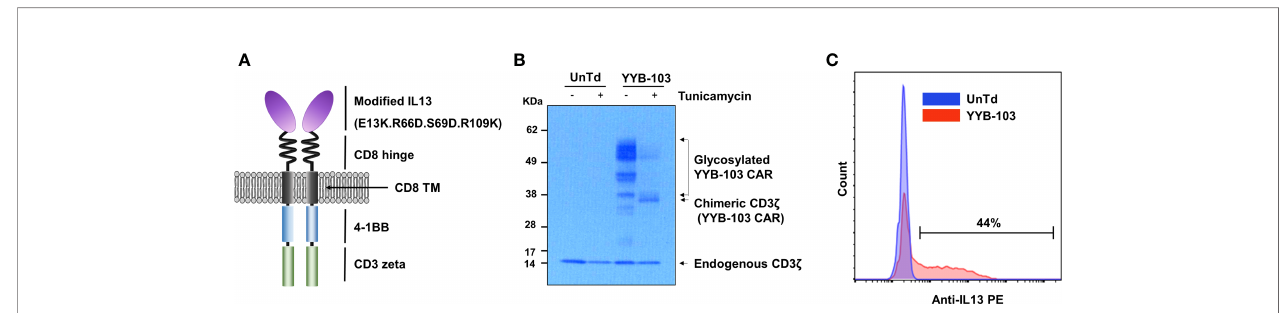
FIGURE 1 | Construction of YYB-103 CAR T cells. (A) Schematic diagram of YYB-103 with modi fi ed IL13. (B) Western blotting analysis of YYB-103. Human peripheral blood mononuclear cells were transduced with YYB-103 retrovirus in the presence or absence of tunicamycin for 24 h, and Western blotting was performed with anti-human CD3 z antibody and HRP-conjugated secondary antibody. (C) Flow cytometric analysis of YYB-103 expression on the cell surface of T cells. CAR, chimeric antigen receptor; HRP, horseradish